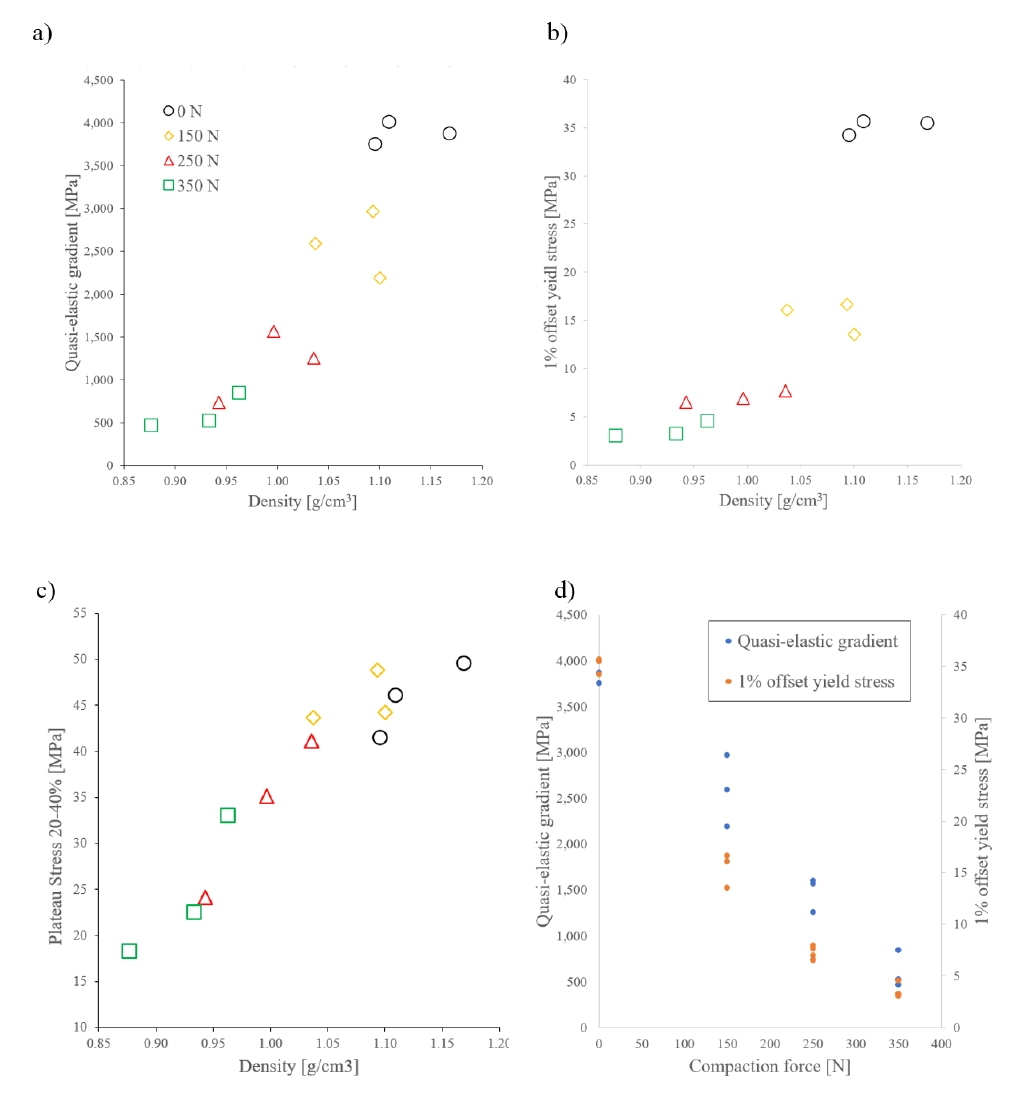
Figure 8. Effective mechanical properties of the compressed syntactic foam samples. Figure 8. E ff ective mechanical properties of the compressed syntactic foam